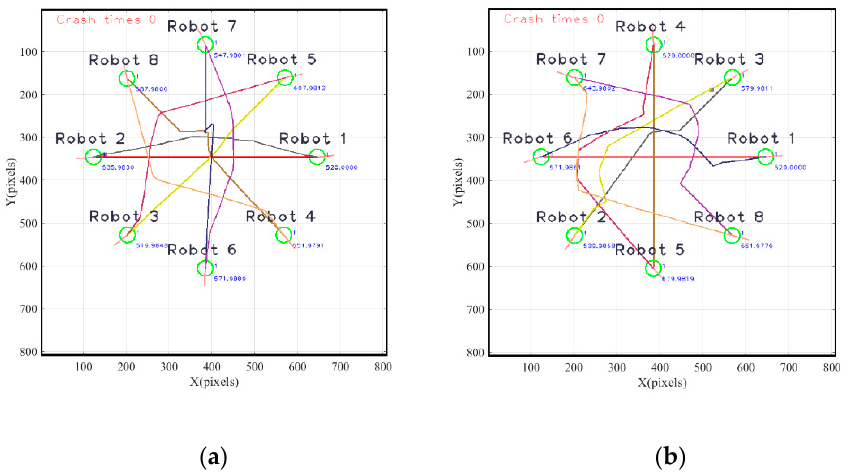
Figure 15. The results of eight robots. ( a ) The best result of NSPP(14632875) and ( b ) the worst result of